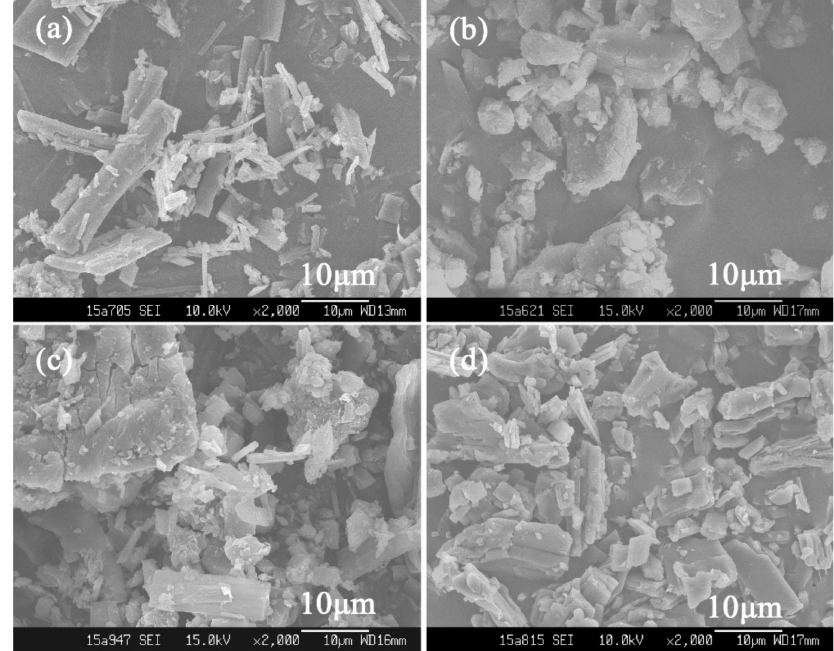
Figure 1. Scanning electron microscopy (SEM) images of ( a ) raw berberine (BBR); ( b ) β -cyclodextrin ( β -CD); ( c ) a physical mixture (1:1, n / n ) of BBR and β -CD; and ( d ) inclusion complexes of BBR